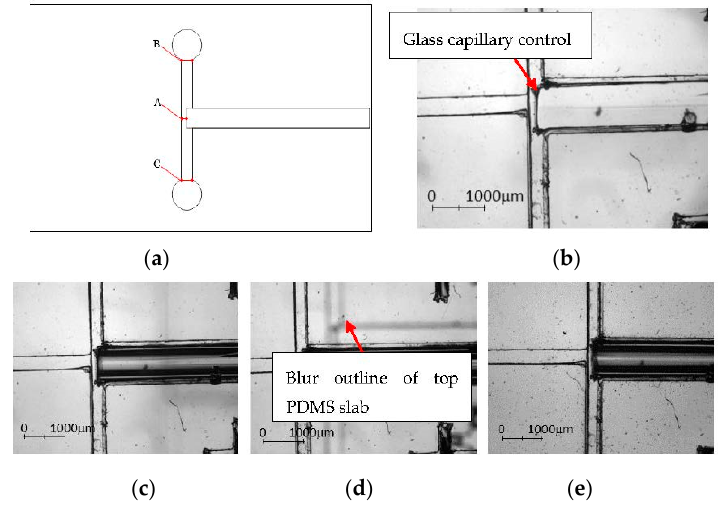
Figure 8. ( a ) Schematic diagram of the locations measured for the aligner precision analysis; ( b ) microscopic image of the bottom PDMS layer; ( c ) microscopic image of the bottom PDMS layer with glass capillary aligned on the channel; ( d ) microscopic image of aligning another layer of PDMS on the top; and ( e ) microscopic image of an aligned device.